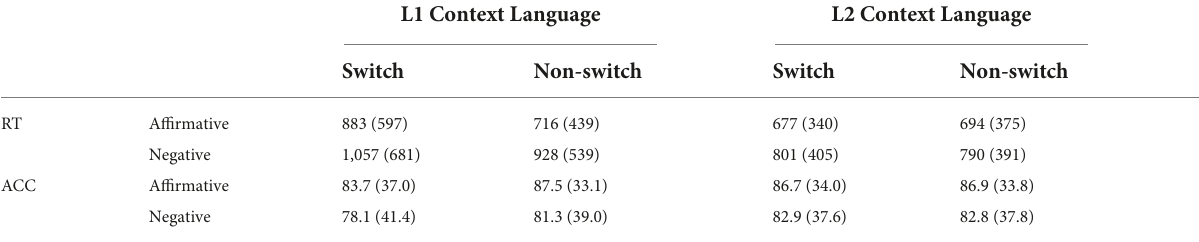
TABLE 2 Mean RTs (ms) and ACCs (%) in the Affirmative and Negative responses deposed by Language Sequence and Context